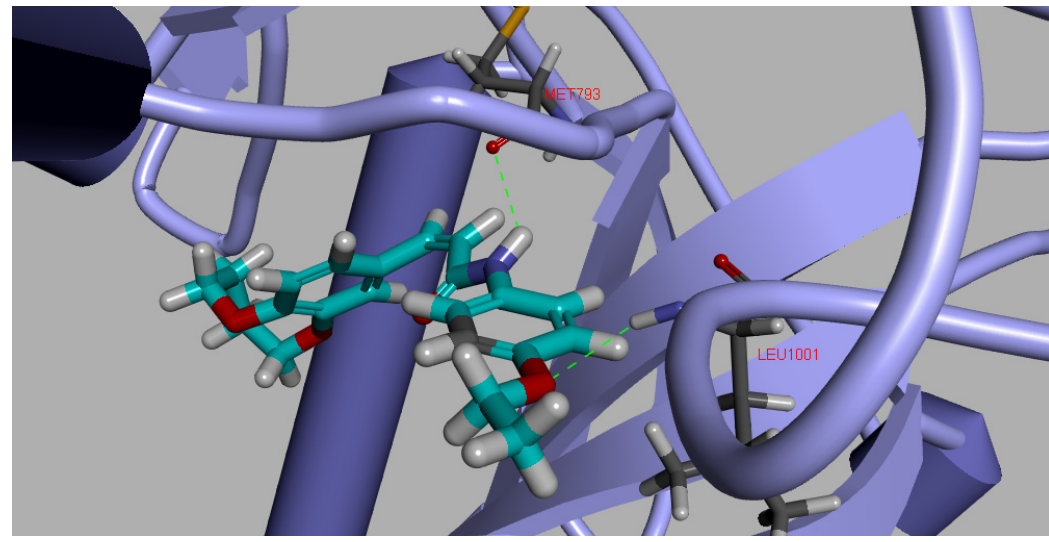
and 2J6M bonding 9